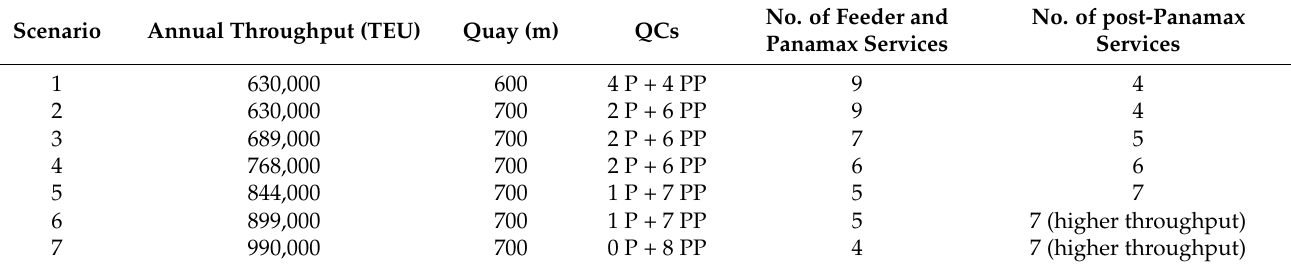
Table 1. The seven performed